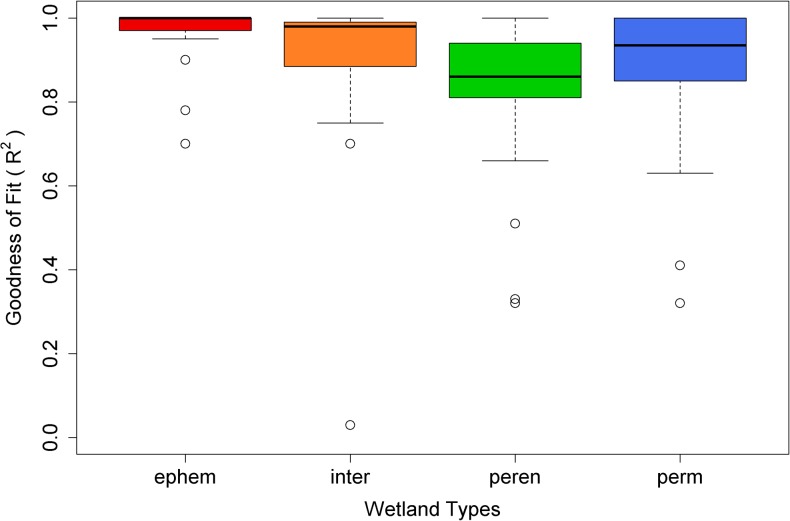
Boxplot of goodness of fit (R2) between observed and simulated data for each wetland type.